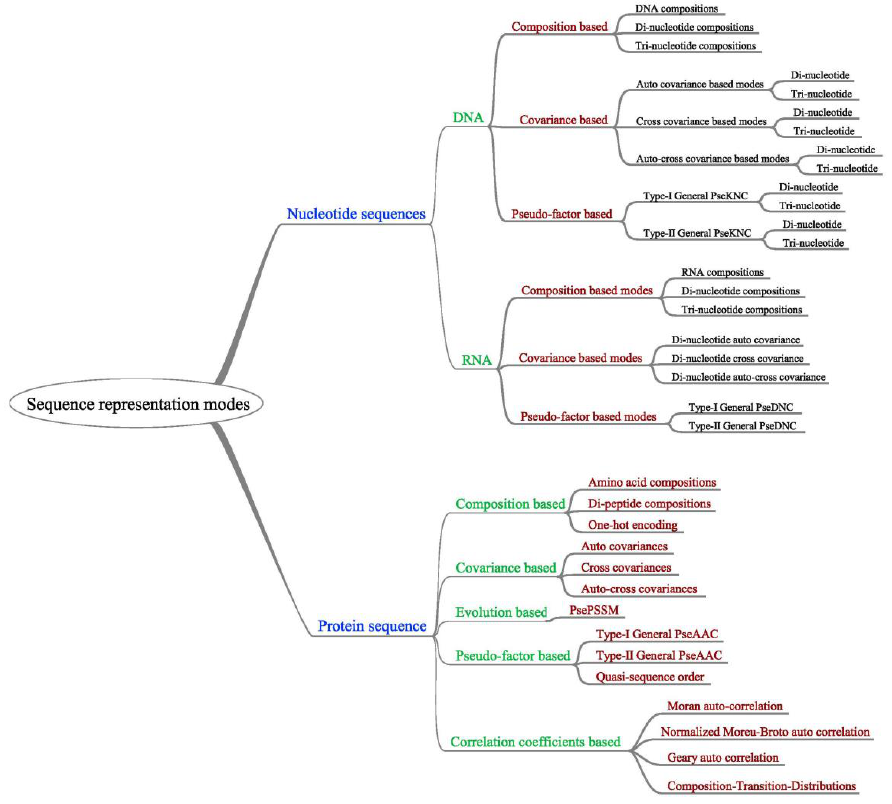
Figure 2. Hierarchical organization of integrated sequence representation modes. UltraPse integrated the sequence representation modes in its distribution package. Most of these modes can also be applied in user-defined sequence types, as long as the users provide proper definitions of the physicochemical